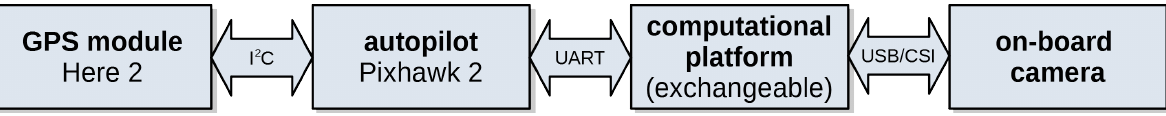
Figure 3. Block diagram of the system with all the essential blocks and